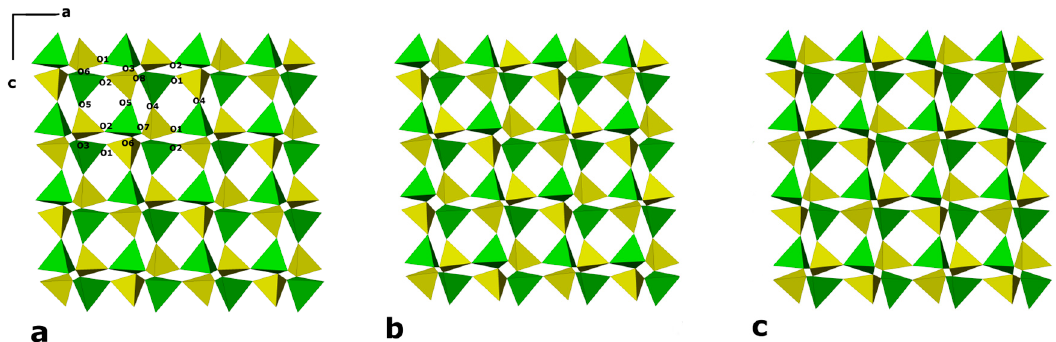
Figure 2. Projection of the amicite structure along the [010] direction at ( a ) P amb , ( b ) 1.25 GPa, and ( c ) 4.71 GPa. The projection of the structure at P amb (rev) is not reported, this being virtually identical to that at P amb .